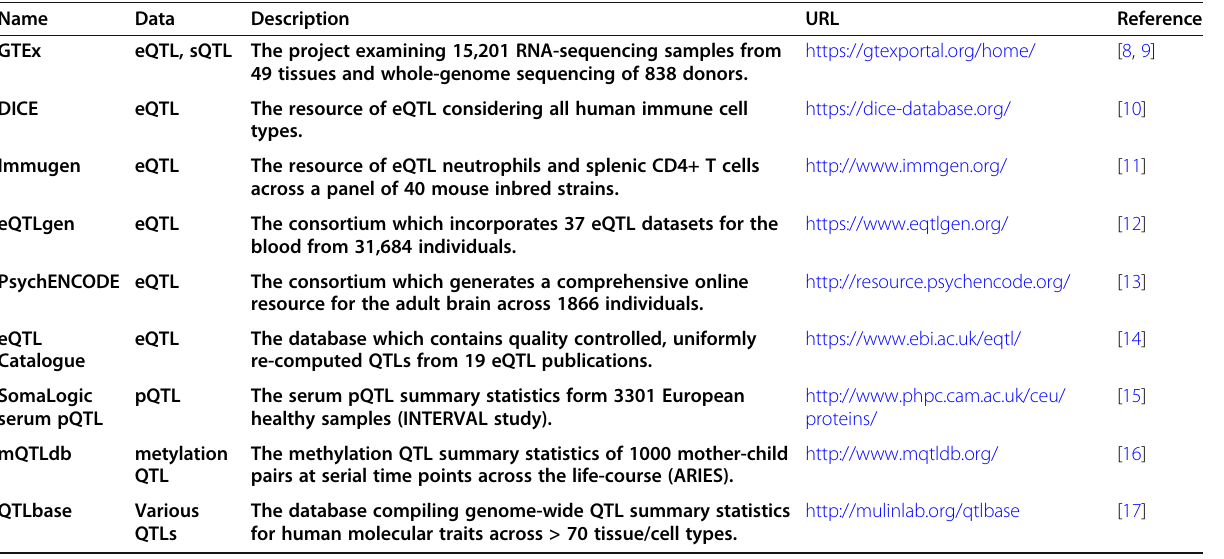
Table 1 Useful resources and databases related to